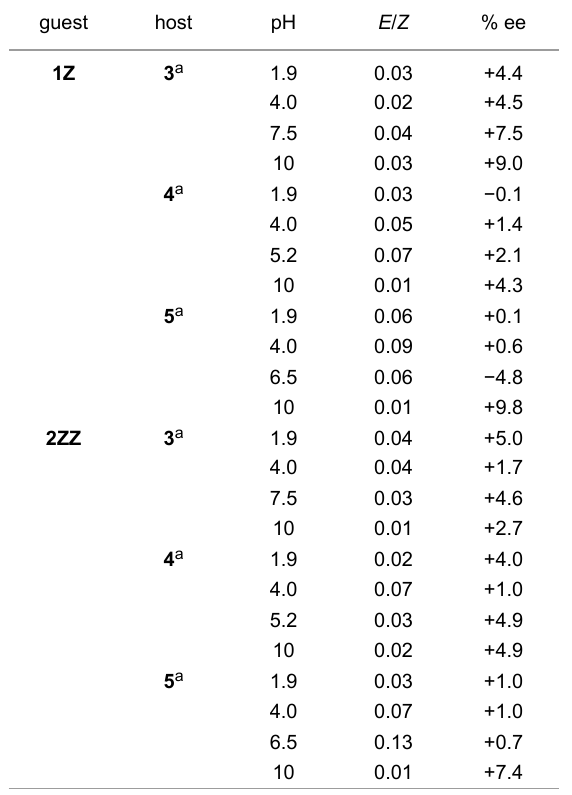
Table 1: Enantiodifferentiating photoisomerization of 1Z and 2ZZ sensitized by CDNSs in aqueous solution at different pH values. guest